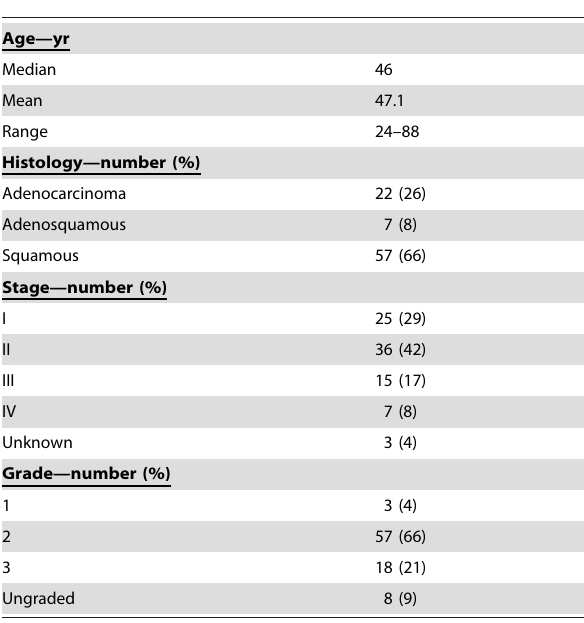
Table 1. Characteristics of 86 Patients in the Study